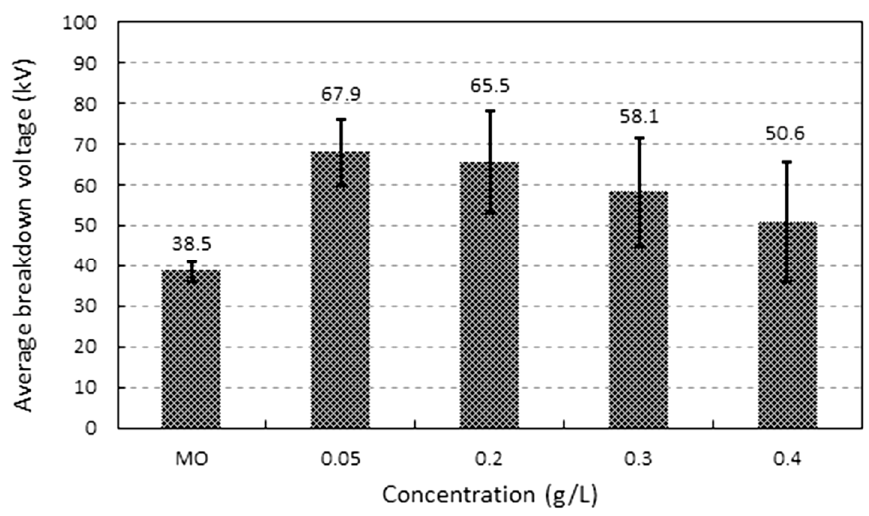
Figure 8. The breakdown voltages of MO/Al 2 O 3 (13 nm) NFs.